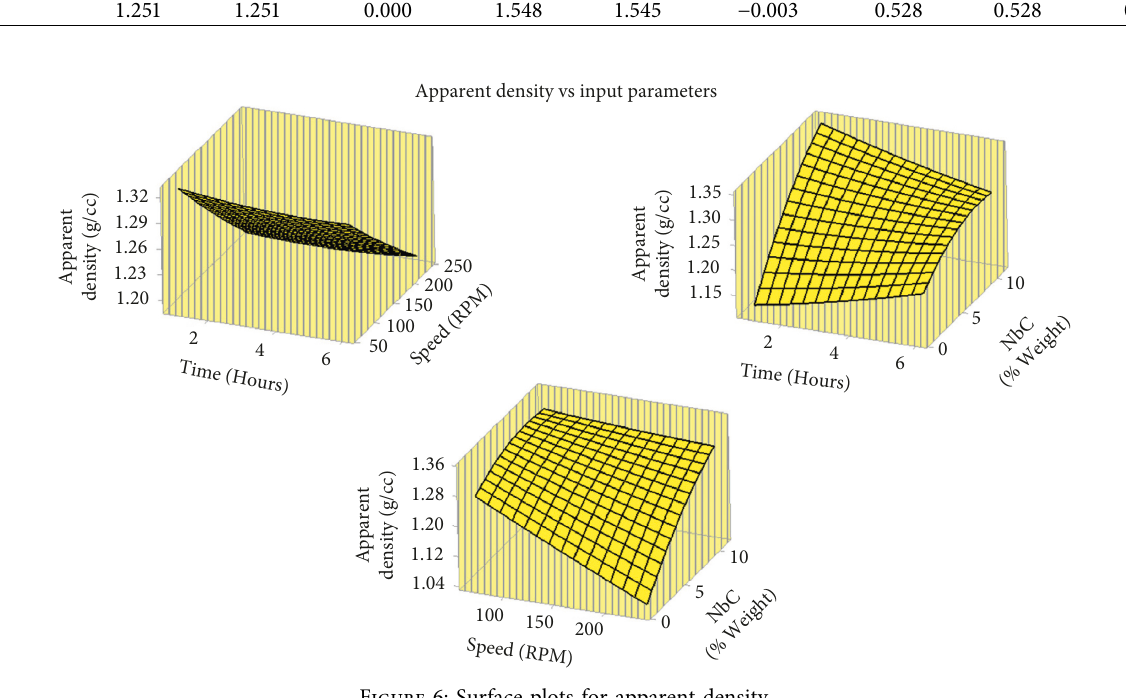
Figure 6: Surface plots for apparent density.